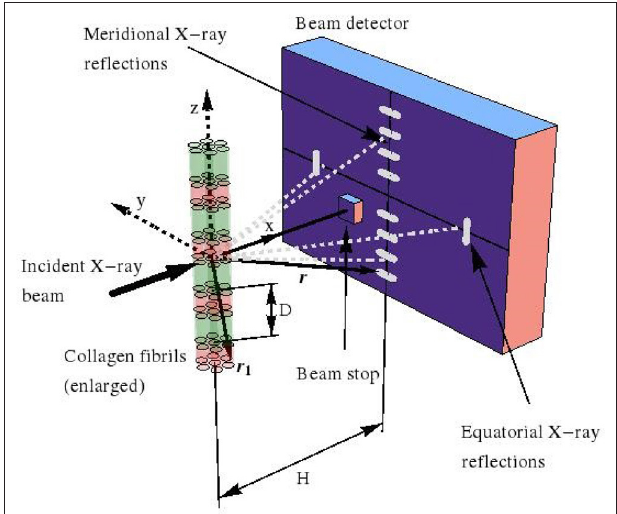
FIGURE 1 | Small angle X-ray scattering (SAXS) device, used for investigation of fibrillar collagen structures.